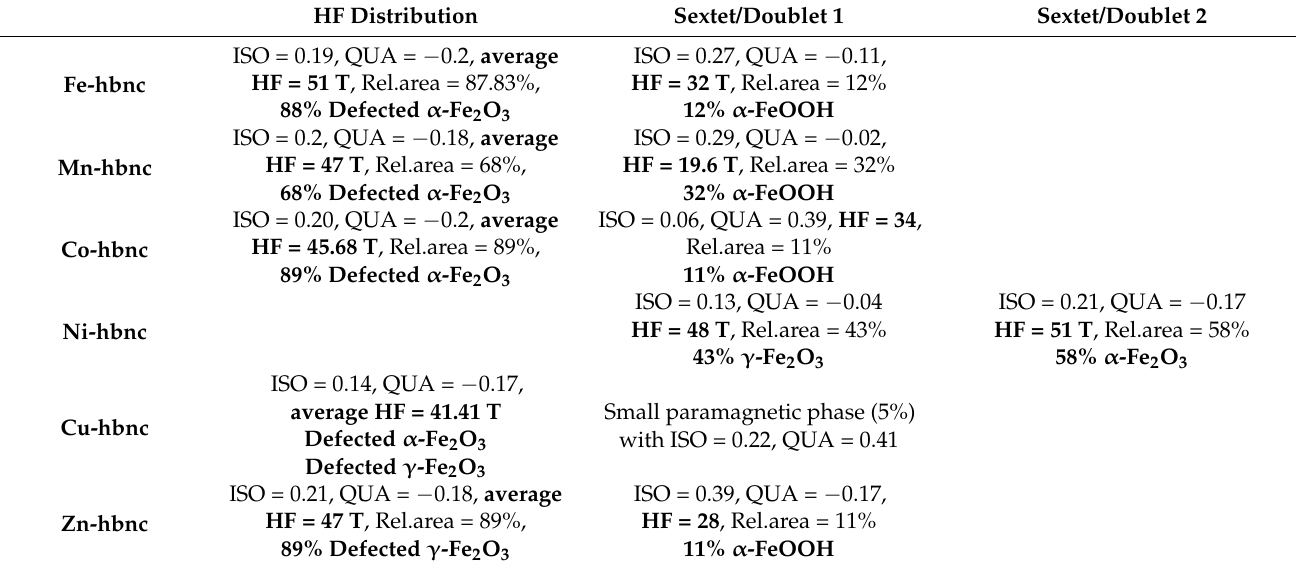
Table 2. Mössbauer hyperfine parameters (ISO-isomer shift (mm/s), QUA-quadrupolar shift (mm/s), HF-hyperfine field (T)) and relative area (%) of the Mössbauer spectral components. In the case of HF distribution, the two values provided for HF max correspond to the two most probable hyperfine fields. Sextet/Doublet 1 Sextet/Doublet 2